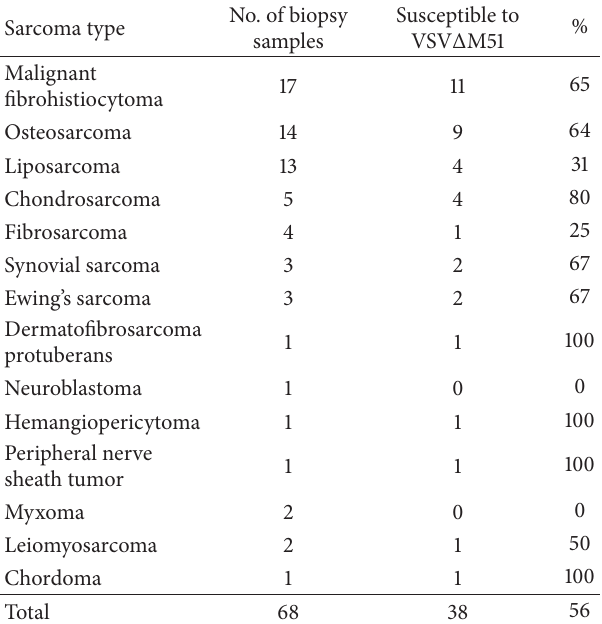
Table 1: VSV Δ M51 infects multiple types of ex vivo human sar- comas. Approximately 50% of the ex vivo specimens tested are susceptible to VSV Δ M51